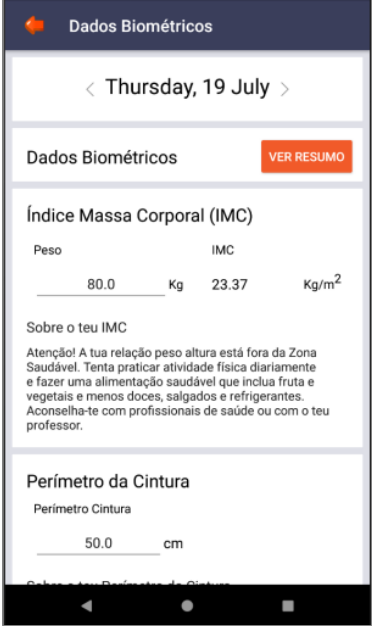
vegetables=”hortícolas”, cereals=”cereais”)— mental model.